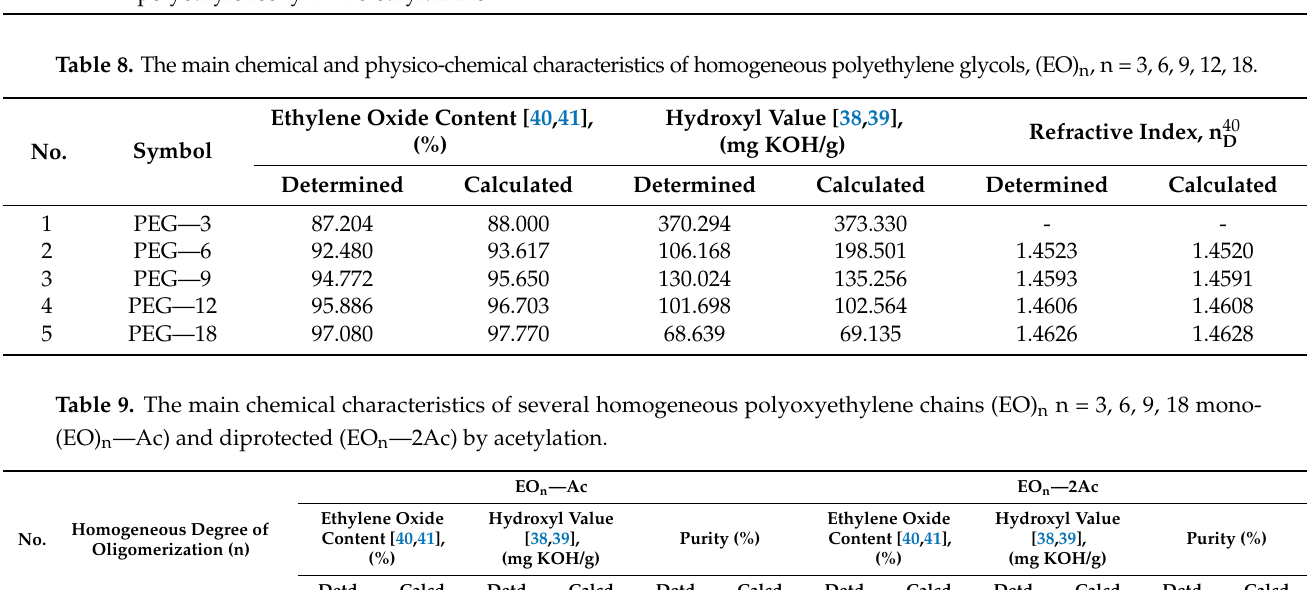
No. Homogeneous Degree of Oligomerization (n)